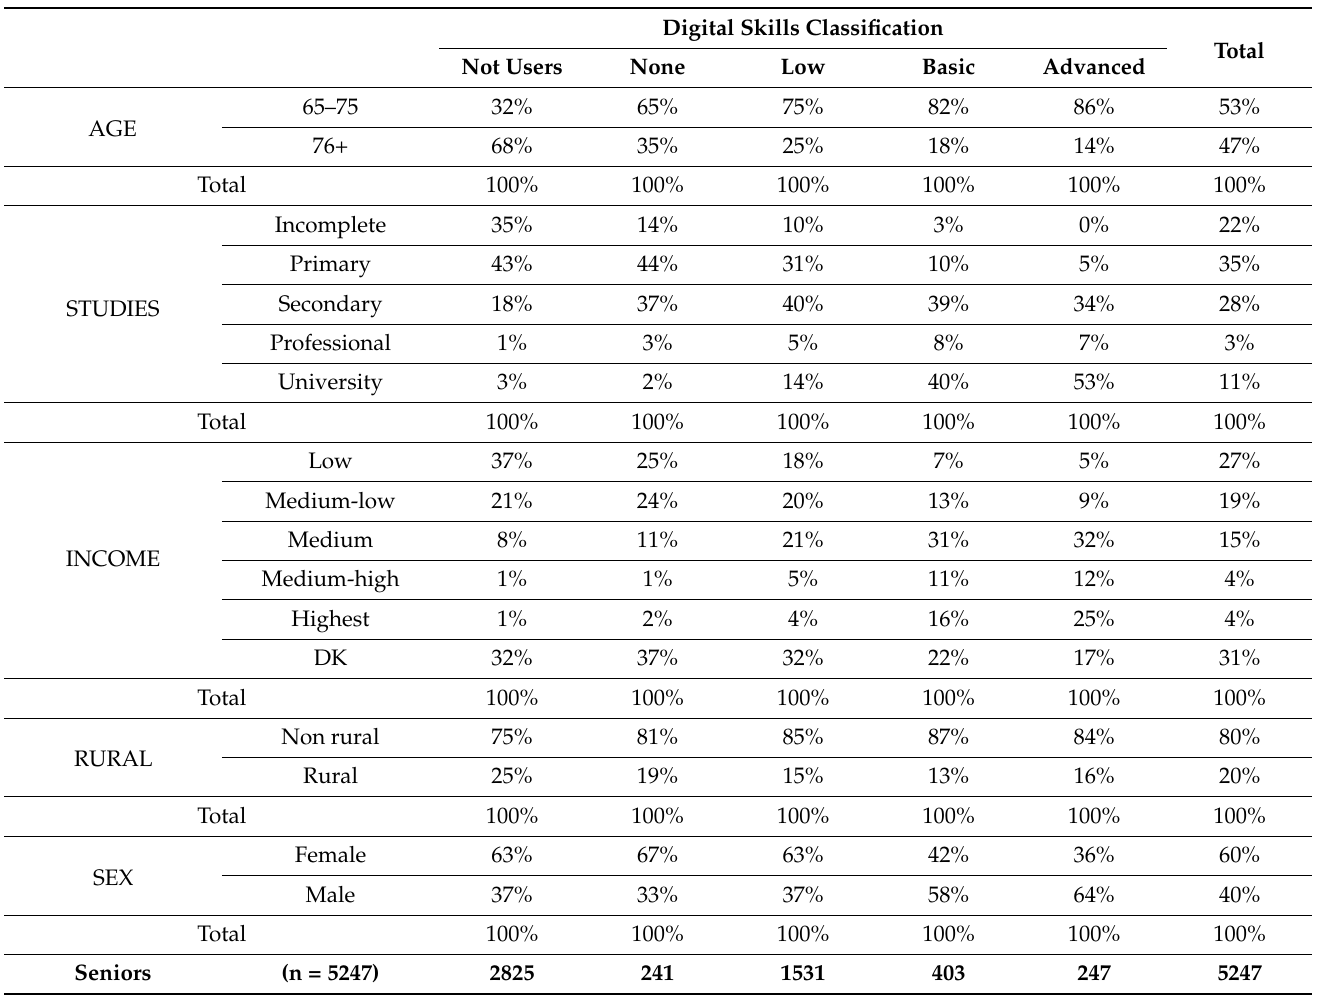
Table 6. Digital skills classification by digital divides.